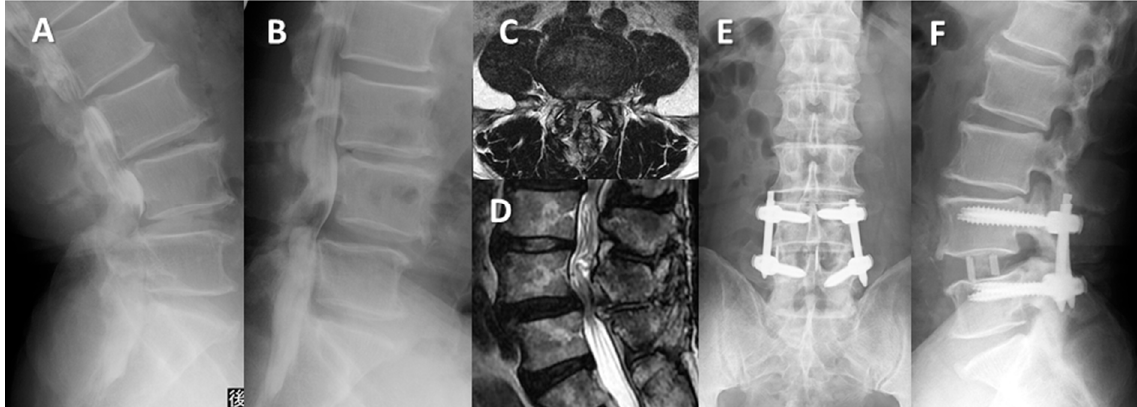
Figure 6. Seventy-three-year-old man with lumbar degenerative spondylolisthesis following posterior decompression surgery: ( A , B ) Preoperative myelogram lateral findings showing L4/L5 spondylolisthesis with 20% vertebra slippage and translation. ( C , D ) Magnetic resonance imaging showed severe stenosis at L4/L5. ( E , F ) Lateral radiograph two years after surgery showed no correction loss of slippage.